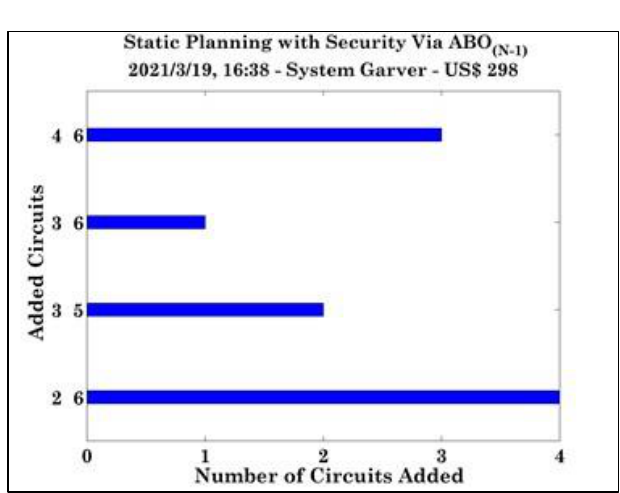
Figure 4: G-6/15 system - Planned circuits.